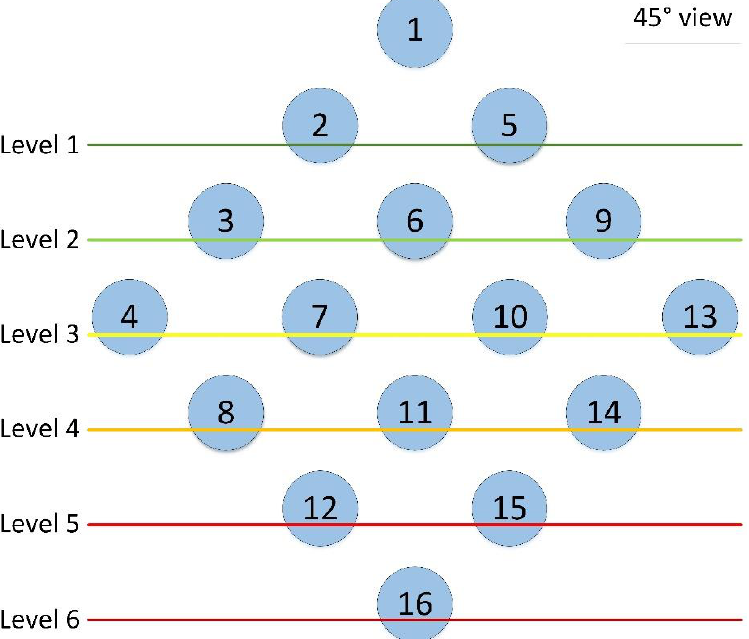
Figure 7 . The propagation direction for each level. Figure 7. The propagation direction for each